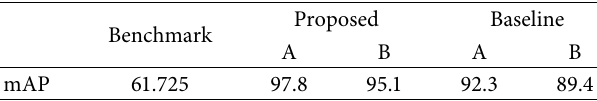
Table 5: mAP results for both